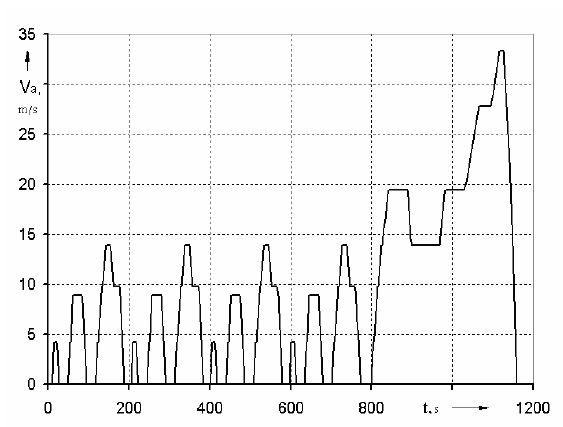
Fig 15 . New European driving cycle (NEDC)